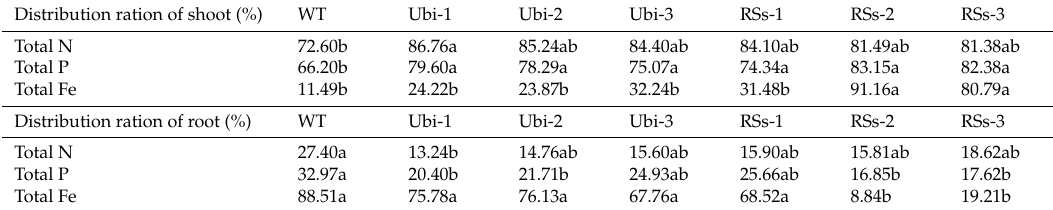
Table 1. The e ff ect of 0.2 mM NO 3 − treatment on the distribution of total N, P, and Fe in shoots and Table 1. The effect of 0.2 mM NO 3 ‐ treatment on the distribution of total N, P, and Fe in shoots and roots. Significant di ff erences between the transgenic and WT lines are indicated by di ff erent letters roots. Significant differences between the transgenic and WT lines are indicated by different letters ( p ( p < 0.05, one-way ANOVA) < 0.05, one ‐ way ANOVA) Distribution ration of shoot (%) WT